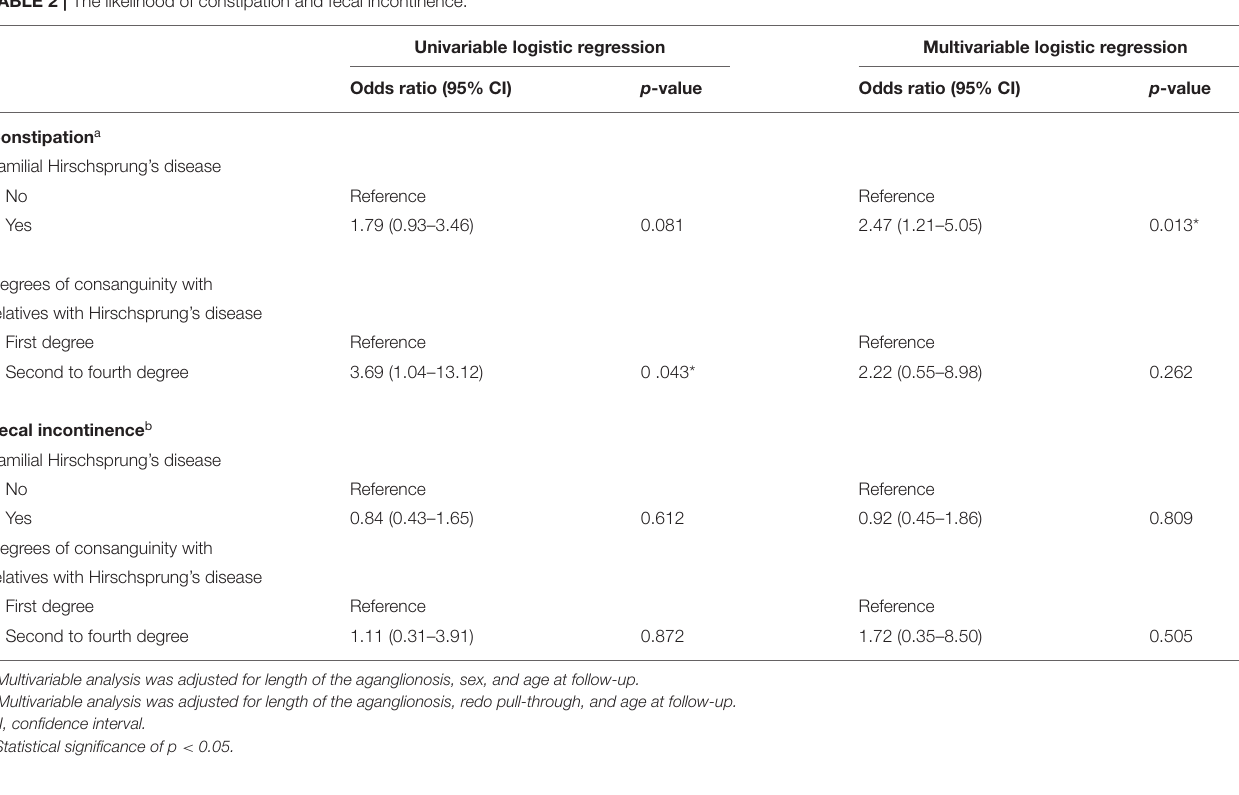
TABLE 2 | The likelihood of constipation and fecal incontinence.